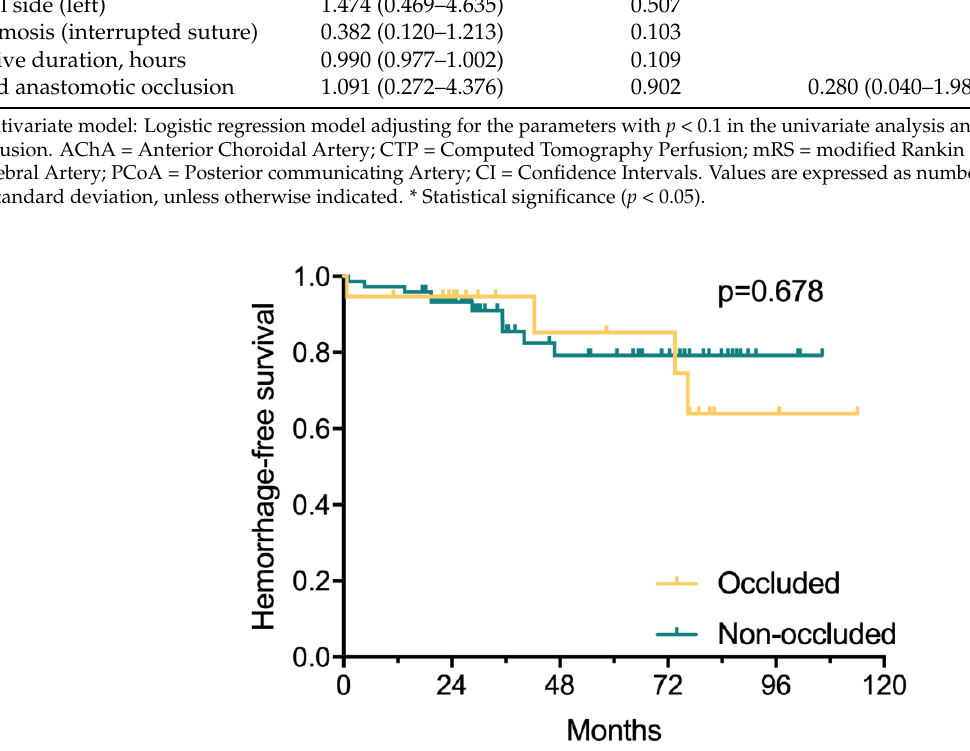
Figure 2. Kaplan–Meier plot showing that there was no significant difference in postoperative hemorrhage-free survival between the occluded and non-occluded group, ( p = 0.678, log-rank test). The markers in the figure indicate the length of the last follow-up for data from hemorrhage-free patients in the two